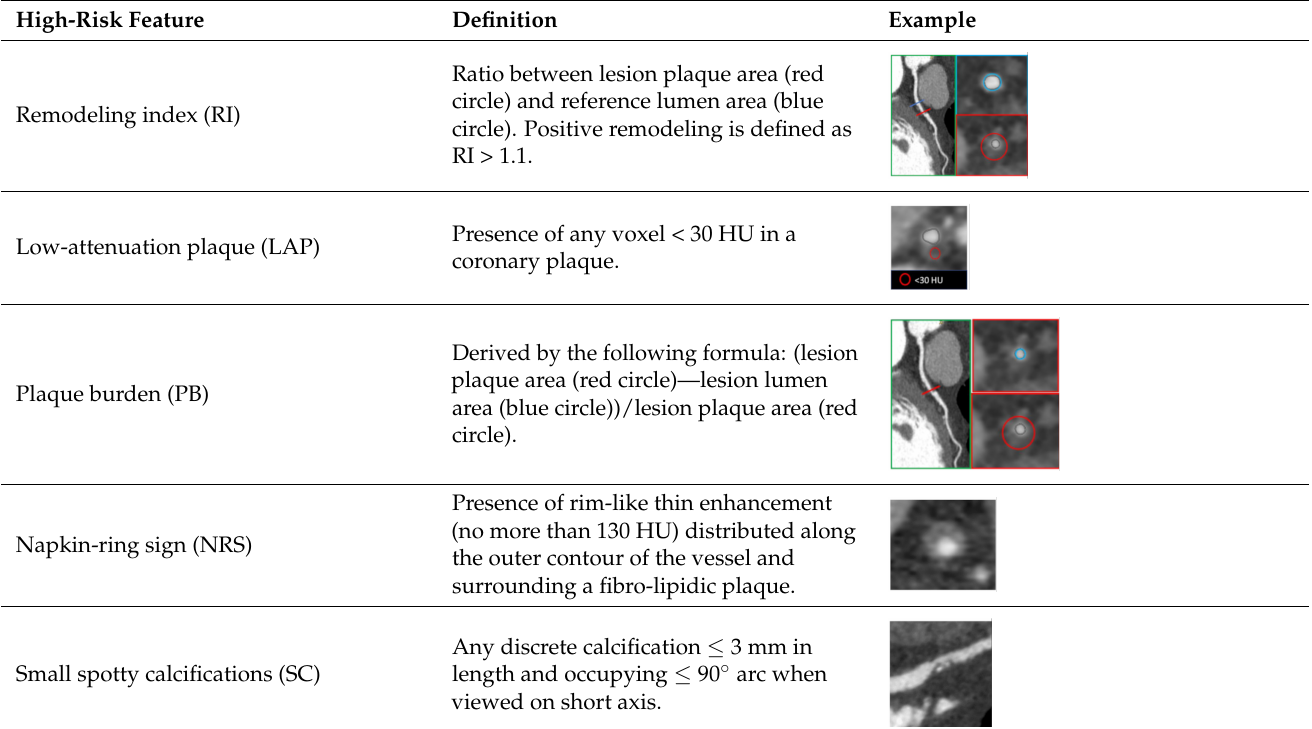
Table 3. Qualitative high-risk